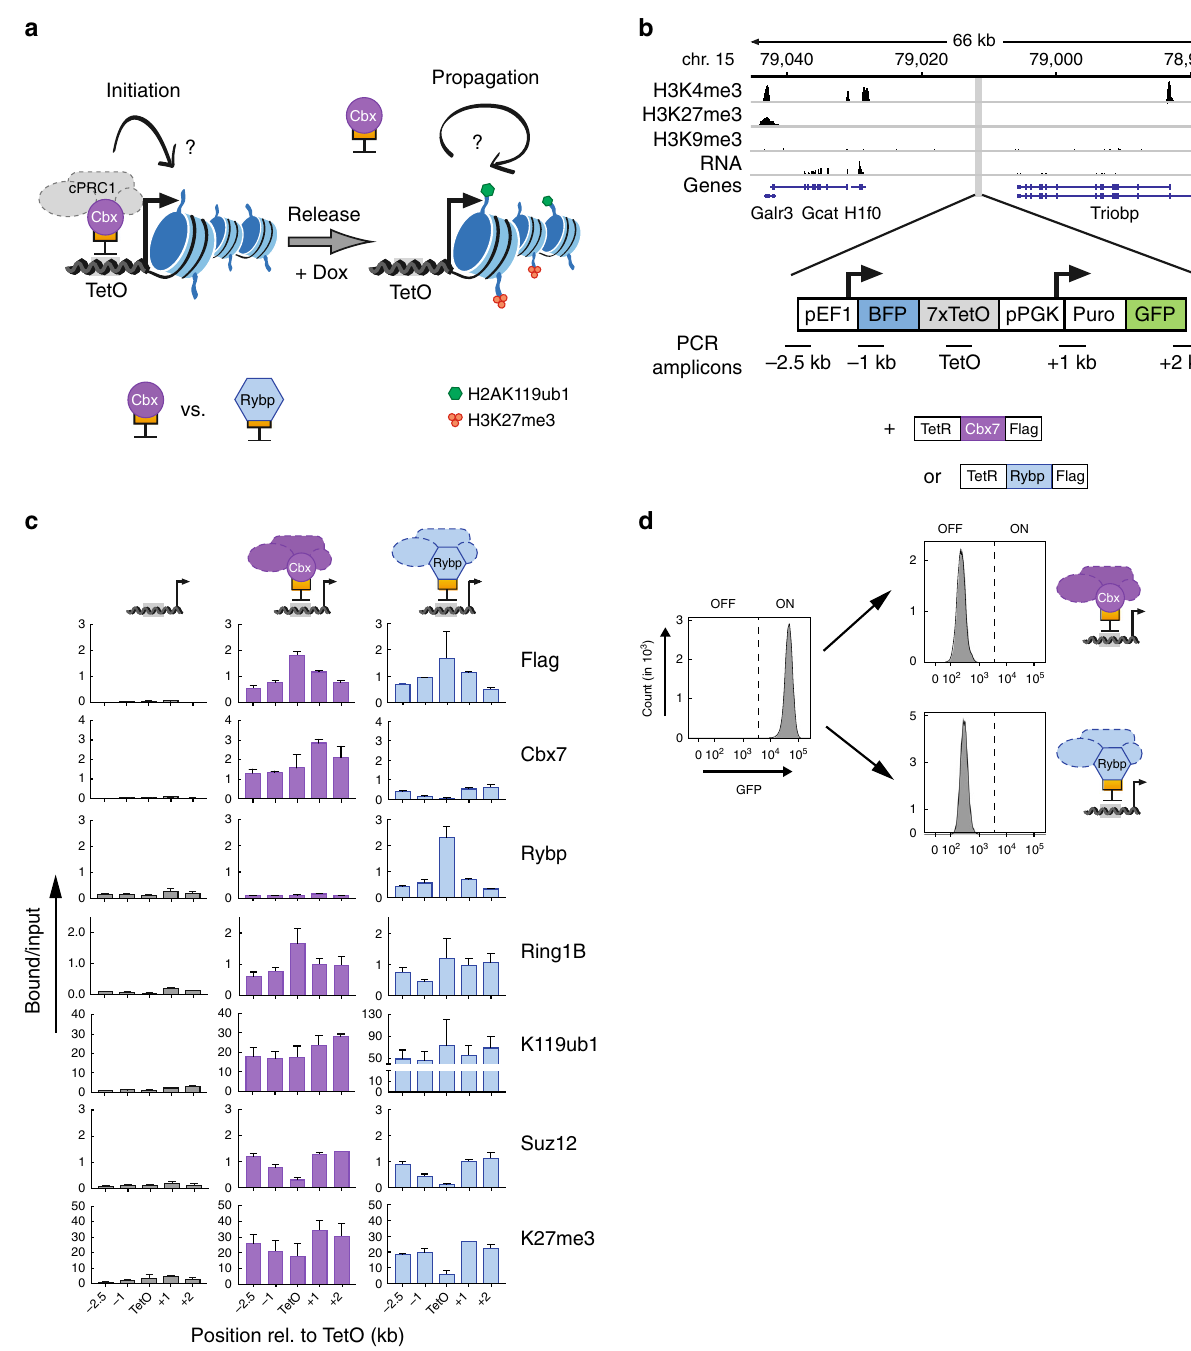
Fig. 1 cPRC1 and vPRC1 establish repressive chromatin and silence reporter genes. a Scheme of experimental design. TetR fusion facilitates reversible tethering of different PcG proteins to Tet Operator sites (TetO) upstream of a reporter gene and tests the consequences of chromatin modi fi cations on transcriptional regulation. Doxycycline (Dox) addition releases TetR binding to determine heritable maintenance of chromatin modi fi cations and expression state in the absence of the initial stimulus. b Histone modi fi cations and RNA expression surrounding the integration site of the dual reporter gene construct located on chromosome 15 in mouse ES cells. c ChIP-qPCR analysis shows relative enrichments of FLAG-TetR fusion, PcG proteins and histone modi fi cations upstream and downstream of the TetO DNA binding sites (TetO). ChIP enrichments for H2AK119ub1 and H3K27me3 are normalized to negative control locus (IAP). Data are mean ± SD (error bars) of at least two independent experiments. Source data are provided as a Source Data fi le. d Flow cytometry histograms of GFP expression in the absence and presence of TetR PcG fusion